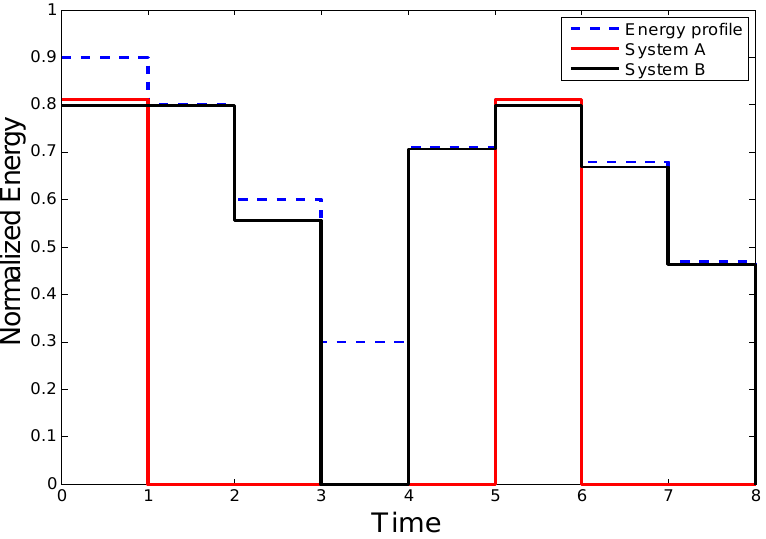
Figure 13. Comparison between conventional systems and energy adaptive system when exposed to variable energy.